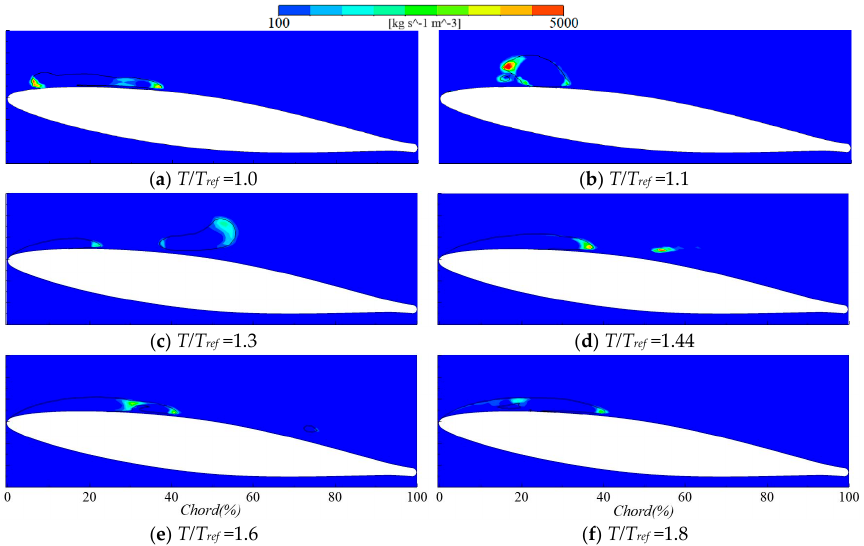
. Figure 6. Contours of (cid:1865)(cid:4662) from vapor to water at different instants of the shedding cycle. Black isolines m from vapor to water at di ff erent instants of the shedding cycle. Black isolines Figure 6. Contours of of α v = 0.1 show the locations of the main vapor cavities at each instant. of α v = 0.1 show the locations of the main vapor cavities at each